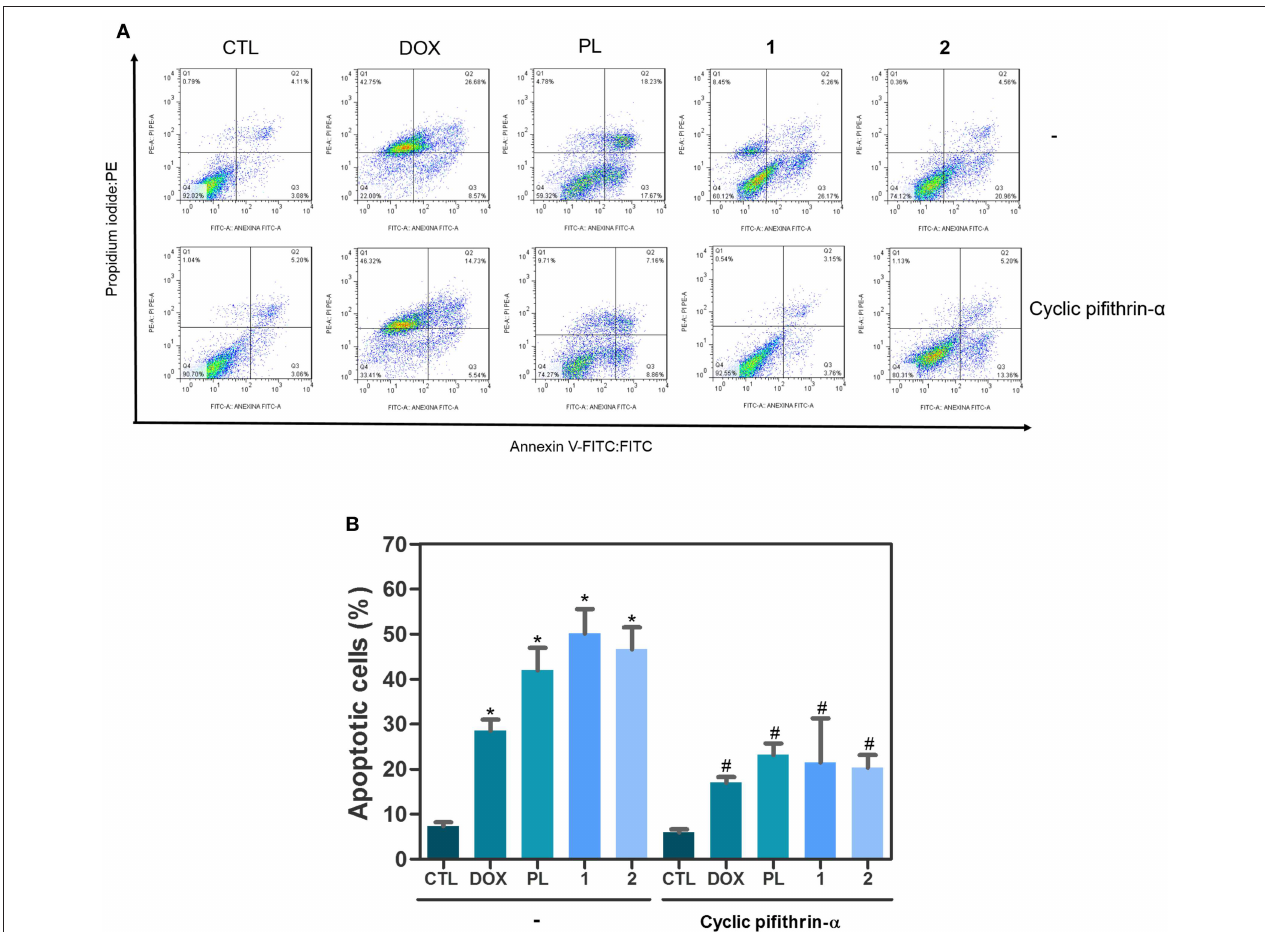
FIGURE 4 | Effect of p53 inhibitor (cyclic pifithrin- α ) in apoptosis induced by ruthenium complexes with piplartine in HCT116 cells, as determined by flow cytometry using Annexin V-FITC/PI staining. (A) Representative flow cytometry dot plots showing percentage of cells in viable (annexin V-FITC negative and PI negative cells), early apoptotic (annexin V-FITC positive, but PI negative cells), late apoptotic (annexin V-FITC positive and PI positive cells), and necrotic stages (PI positive, but annexin V-FITC negative cells). (B) Quantification of apoptotic HCT116 cells (annexin V-FITC positive cells). For protection assays, cells were pretreated for 2h with 10 µ M cyclic pifithrin- α and then incubated with ruthenium complexes at established concentration (2.5 µ M for complex 1 and 5 µ M for complex 2 ) for 48h. Negative control was treated with the vehicle (0.1% of a solution containing 70% sorbitol, 25% tween 80 and 5% water) used for diluting the complexes tested. Doxorubicin (1 µ M) and piplartine (10 µ M) were used as positive controls. Data are presented as mean ± S.E.M. of three independent experiments performed in duplicate. Ten thousand events were evaluated per experiment, and cellular debris was omitted from the analysis. * P < 0.05 compared with negative control by ANOVA, followed